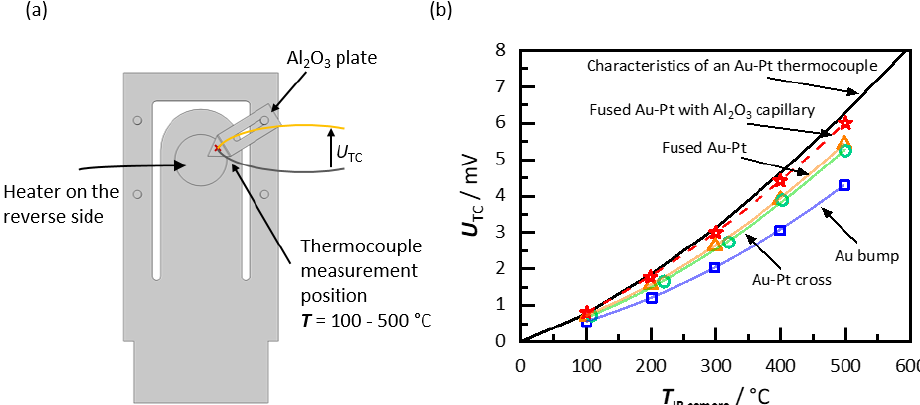
Figure 7. Measurements with the different Au–Pt thermocouple geometries: (a) schematic representation of the setup with a sample holder with integrated heating structure on the bottom side and a fixed thermocouple measurement position, and (b) thermovoltages as obtained by the different thermocouple geometries (see Fig. 6) compared with the Au–Pt characteristics from Gotoh et al. (1991).